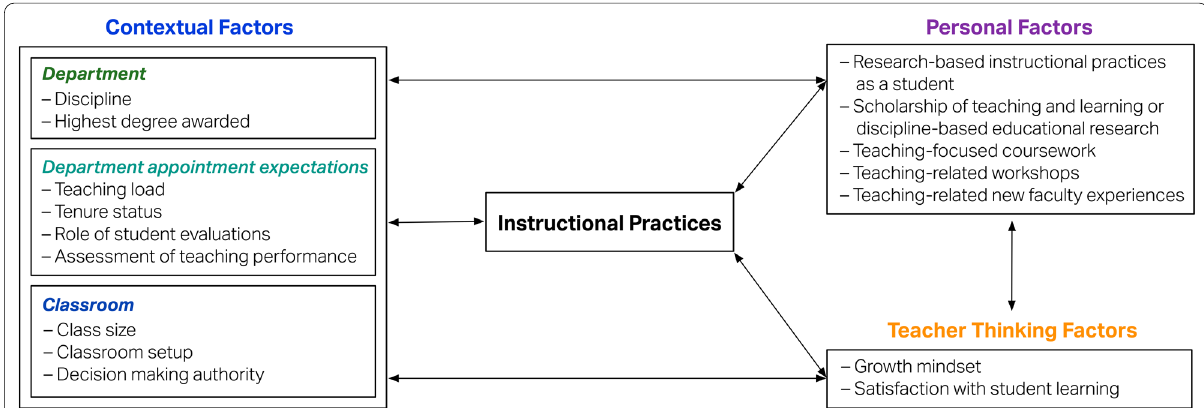
Fig. 1 Conceptualization of the Teacher-Centered Systemic Reform (TCSR) model for change in higher education with control variables (discipline and highest degree awarded) and malleable factors included in this